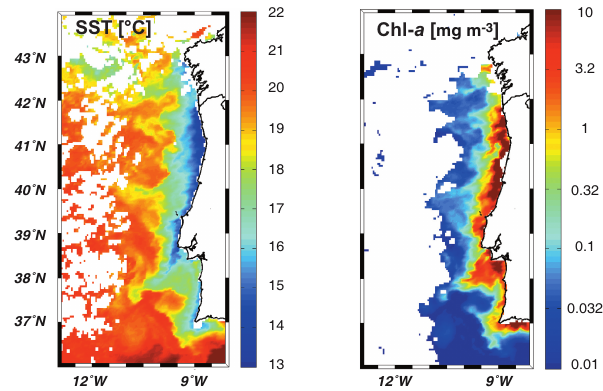
Fig. 2. Satellite images of sea surface temperature (SST) and Chl- a concentration on 19 August 2007. Source: Data from the Moderate Resolution Imaging Spectroradiometer (MODIS) aboard the Aqua satellite (EOS-PM1, NASA). White is cloud cover. Left: SST [ ◦ C]. Right: Chl- a concentration [mgm − 3 ].